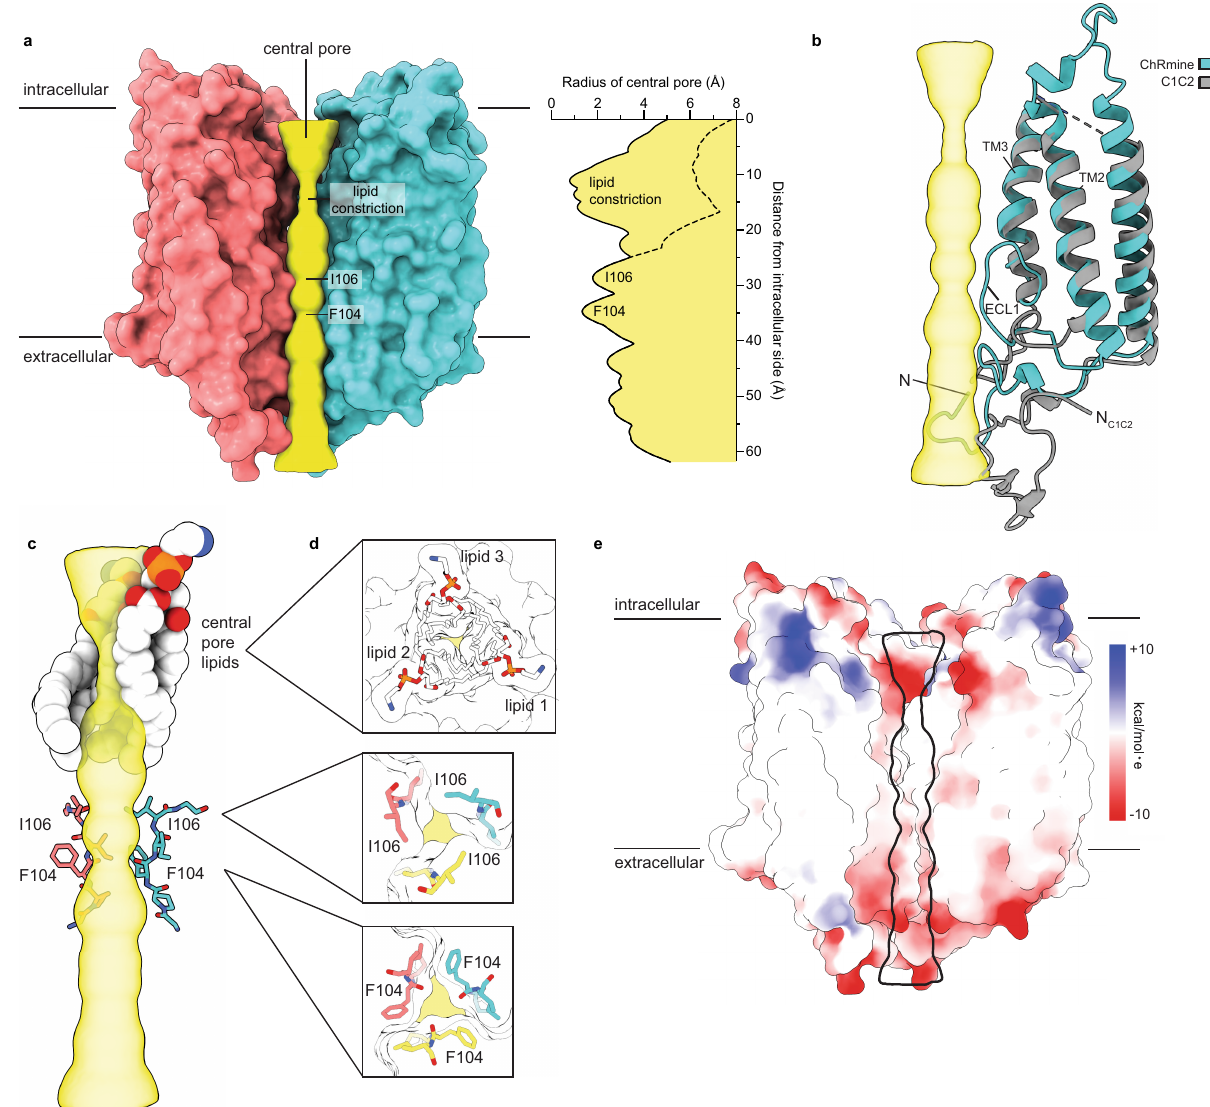
Fig.2|Alipid- fi lledcentralporeinChRmine.a Viewfromthemembraneplaneof theChRminecentralpore(yellow)againstthesurfaceoftwochannelsubunits(the frontsubunitisnotdisplayed).Correspondingporeradiusasafunctionofdistance fromtheintracellularsideisshownonthesamescale. b OverlayofaChRmineanda